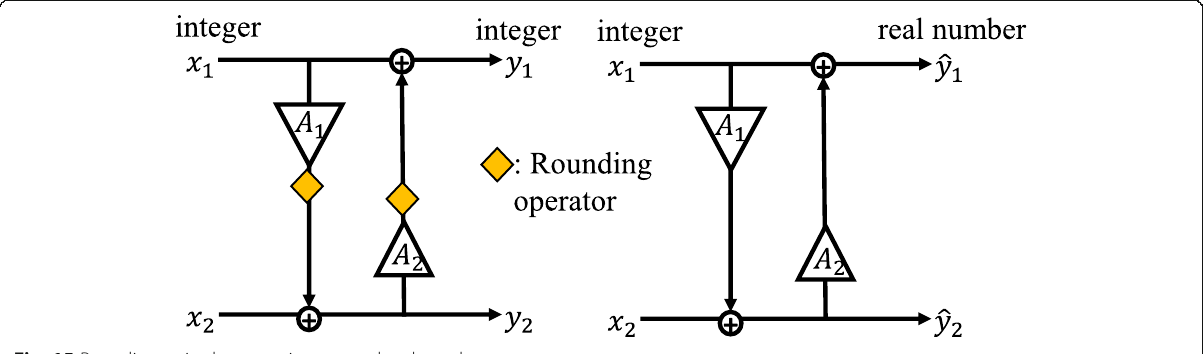
Fig. 15 Rounding noise between integer and real number